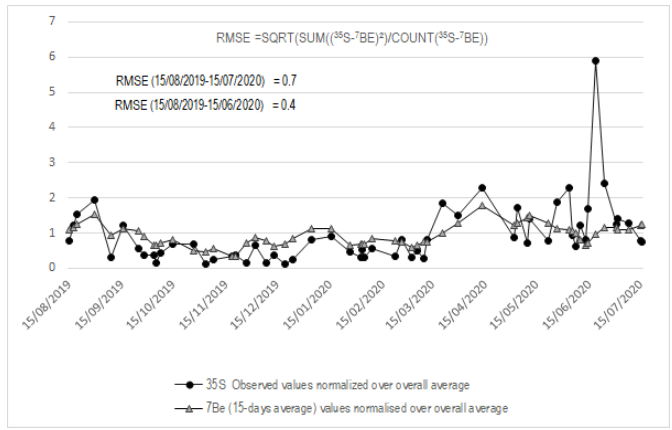
Figure 7. RMSE calculation based on normalized time series of 35 S and 7 Be.